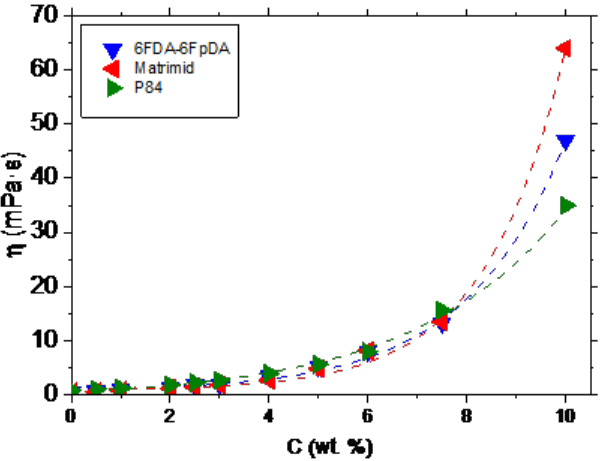
Figure 3. Evolution of the viscosity as a function of the polymer concentration (dotted lines are eye guides only).